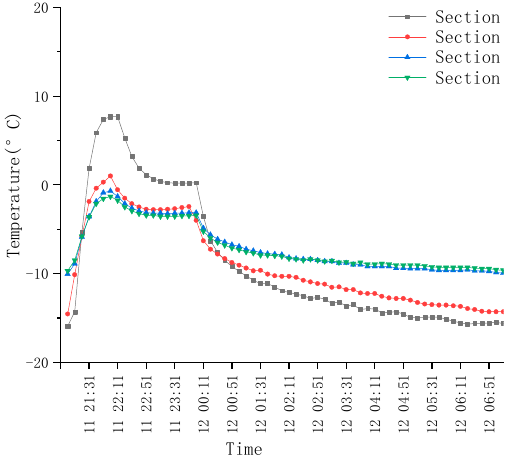
Figure 10. Temperature of model surface. The temperature of the four sections changed regularly and periodically. With the increase in the distance from the air inlet increasing, the fluctuation range decreases. On the other hand, the temperature data behind the lining in Sections 3–6 is presented in Figure 11. The fluctuation of the temperature of each section was synchronous and reached an extreme value at the same time.